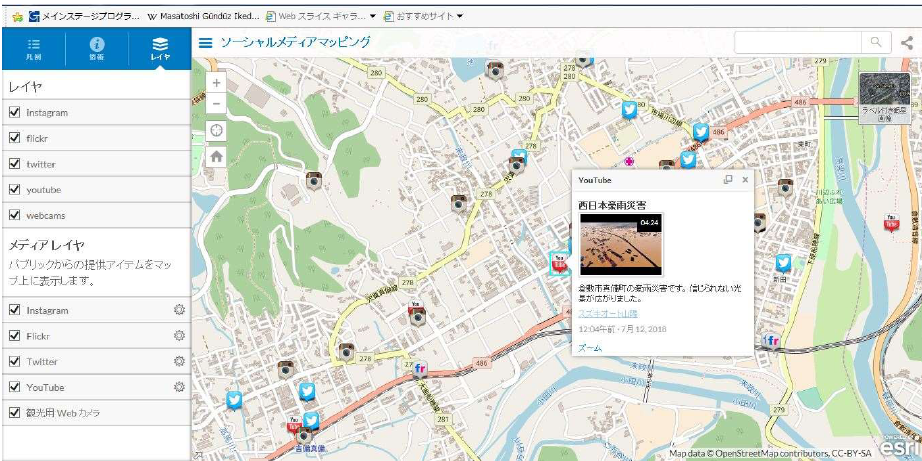
Fig. 4. Information related to the seriously damaged area in Mabi District, Kurashiki City, Okayama Prefecture using